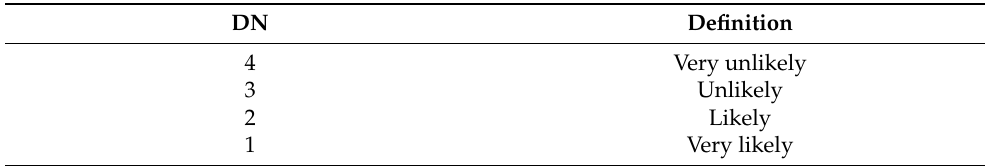
Table 3. Detection numbers and definition.